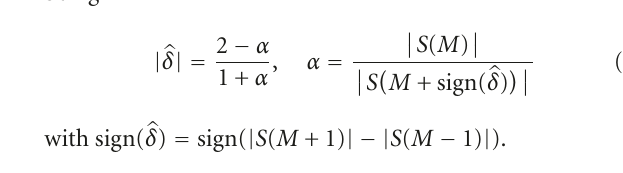
Figure 3: Example of the spectrum (dashed line) and DFT compo- nents ( • ) of a signal.